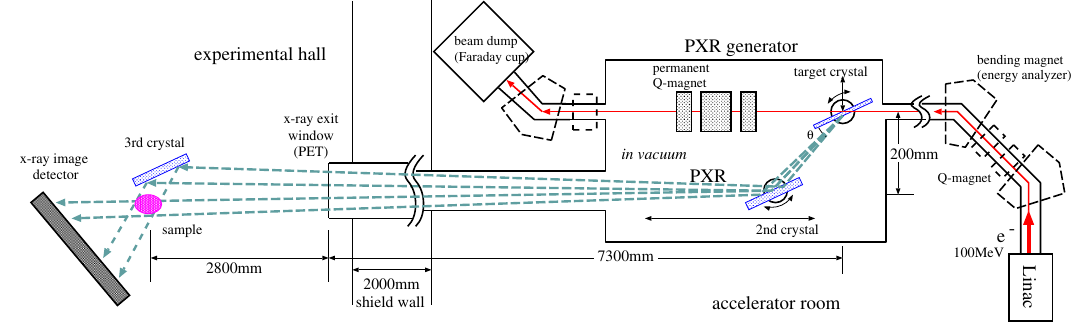
FIG. 1. Schematic top view of the PXR beamline and setup of the simultaneous KES